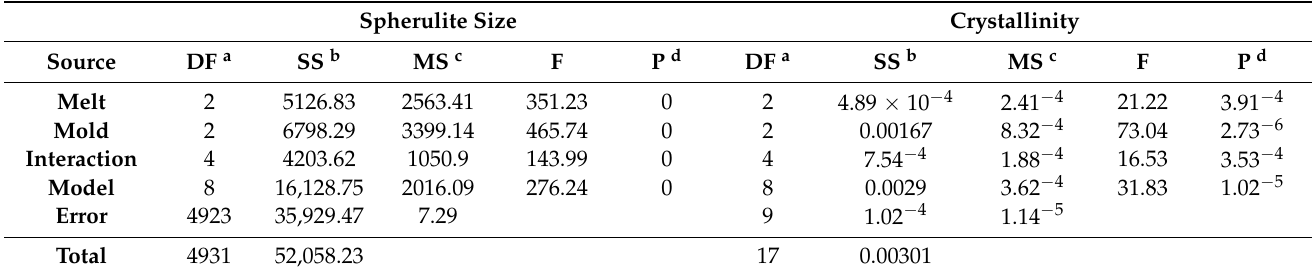
Table 3. ANOVA results determined for the spherulite size and crystallinity degree of LDPE injected-molded specimens. Spherulite Size